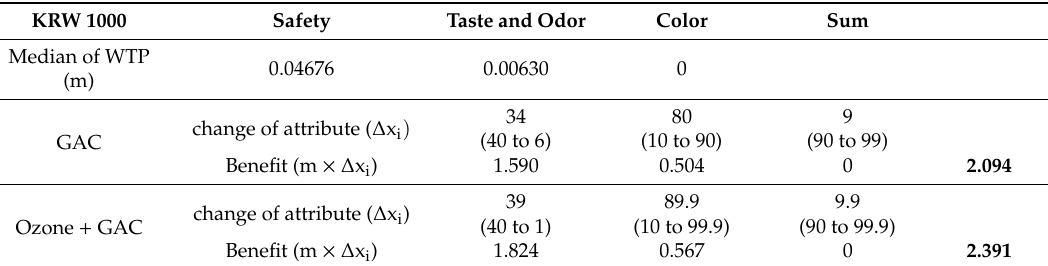
Table 5. Benefits using the median WTPs of the ANA1 model.